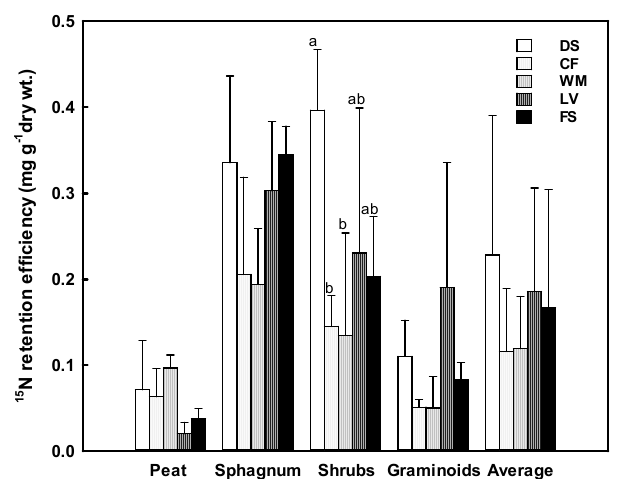
Figure 5. 15 N retention efficiency (mean ± SD, n = 3) of ecosys- tem pools, calculated by dividing retained 15 N in each pool at the end of the experiment by dry mass of the corresponding pool. “Aver- age” represents the mean 15 N retention efficiency of all pools (mean ± SD, n = 4). Letters a and b – significant differences in the mean values of the sites at each pool (one-way ANOVA, Tukey test). A bar without a letter – no significant difference. Site abbreviations as in Fig.